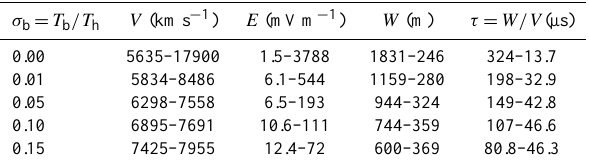
Table 3. Properties of electron-acoustic solitons such as soliton velocity ( V ), electric field ( E ), soliton width ( W ) and pulse du- ration ( τ ) for various values of v o / v th , for the dayside auroral re- gion parameters (Dubouloz et al., 1991, 1993); N oc =0.2cm − 3 , N oh =1.5cm − 3 , N ob =1.0cm − 3 , σ c = T c / T h = T i / T h = σ i =0.001, κ =4, σ b = T b / T h =0.01, hot electron temperature, T h =250eV, cold electron temperature, T c =2.5eV= T i (ion